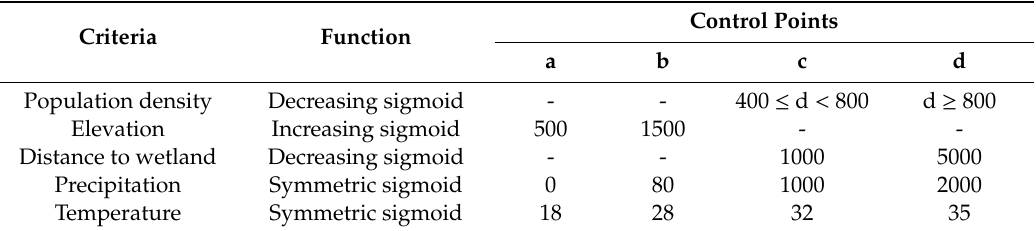
Table 3. Threshold for the fuzzy logic function used in the spatial MCE